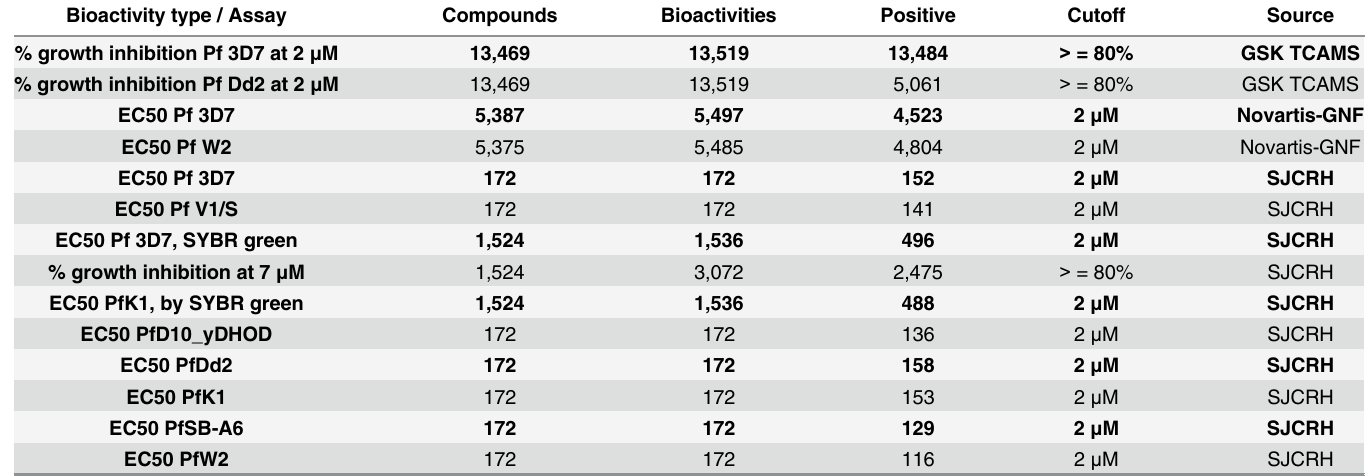
Table 2. Bioactivity types derived from high-throughput screenings against Plasmodium falciparum . Sources are GSK TCAMS: GlaxoSmithKline Tres Cantos Antimalarial Screening [29]; Novartis-GNF: Novartis-GNF Malaria Box dataset [50]; and SJCRH: Saint Jude Children's Research Hospital [30]. Bioactivity type /